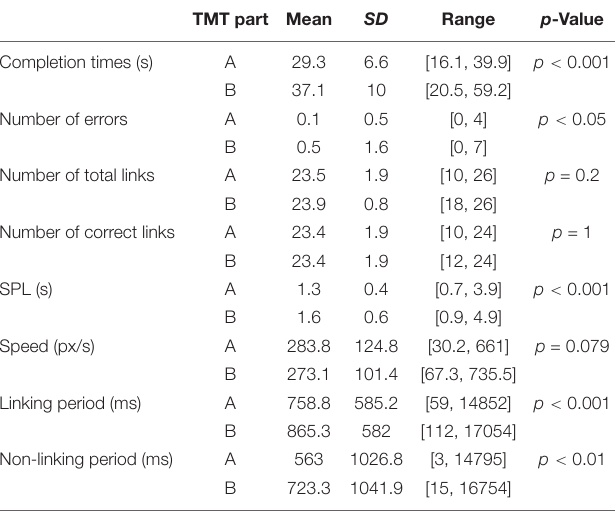
TABLE 1 | Behavioral metrics for participants ( n = 16) performing the tablet